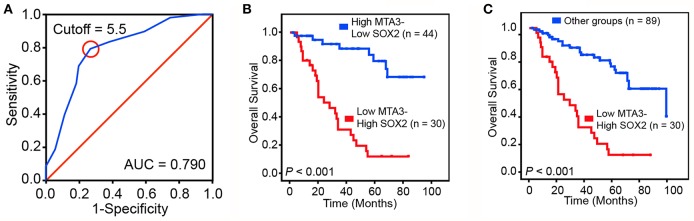
Dysregulated MTA3-SOX2 axis is associated with poor prognosis. (A) Receiver operating characteristic (ROC) curve analysis was performed to determine the cut-off score for the low expression of SOX2. (B,C) The overall survival of TSCC patients with tumors expressing low levels of MTA3 and high levels of SOX2 and those with high levels of MTA3 and low levels of SOX2 (B), as well as all other subjects (C).